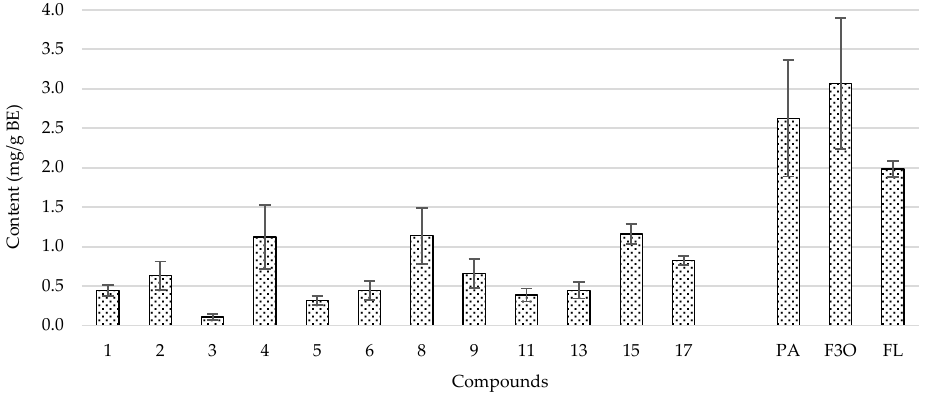
Figure 2. Mean composition in phenolic compounds of quince peel bioactive extracts (BEs) obtained with the six replicates of the center point of the design. 1 : cis -3- O -caffeoylquinic acid; 2 : trans -3- O -caffeoylquinic acid; 3 : 3- O - p -coumaroylquinic acid; 4 : cis -5- O -caffeoylquinic acid; 5 : trans -5- O -caffeoylquinic acid; 6 : (+)-catechin; 8 : β -type (epi)catechin trimer; 9 : β -type (epi)catechin tetramer; 11 : β -type (epi)catechin tetramer; 13 : β -type (epi)catechin trimer; 15 : quercetin- O -deoxyhexosil-hexoside; 17 : kaempferol- O -deoxyhexosil-hexoside. PA: phenolic acids; F3O: flavan-3-ols; FL: flavonols.